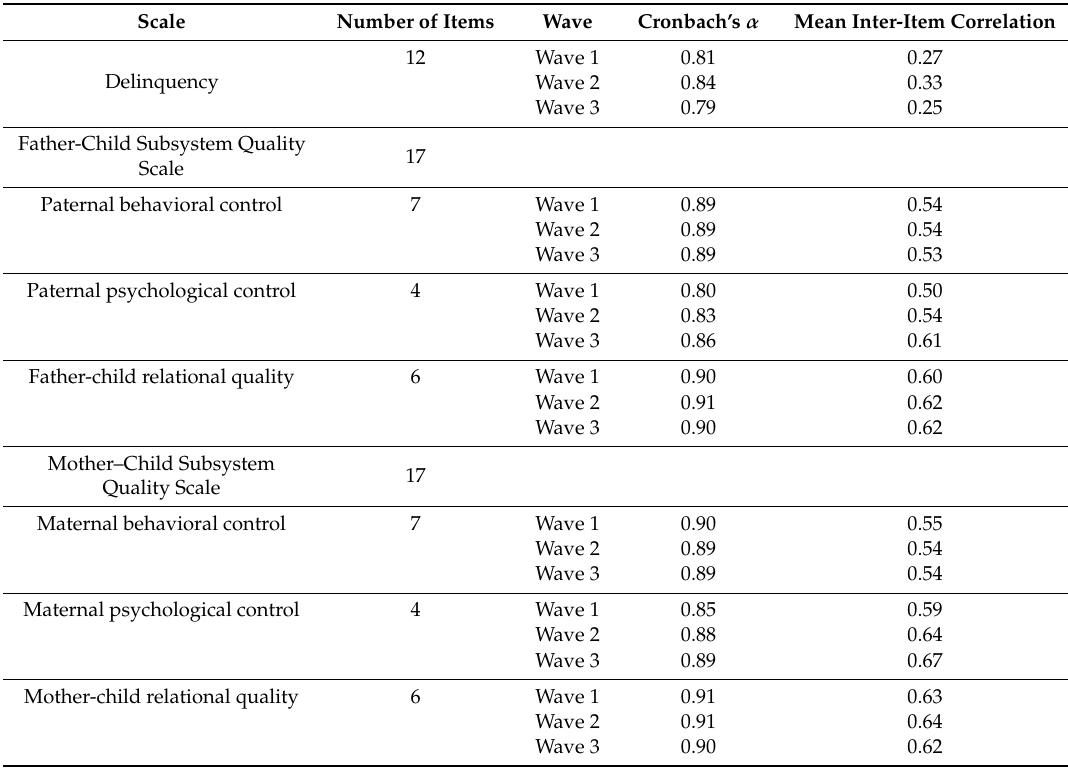
Table 2. Reliability of scales across the three